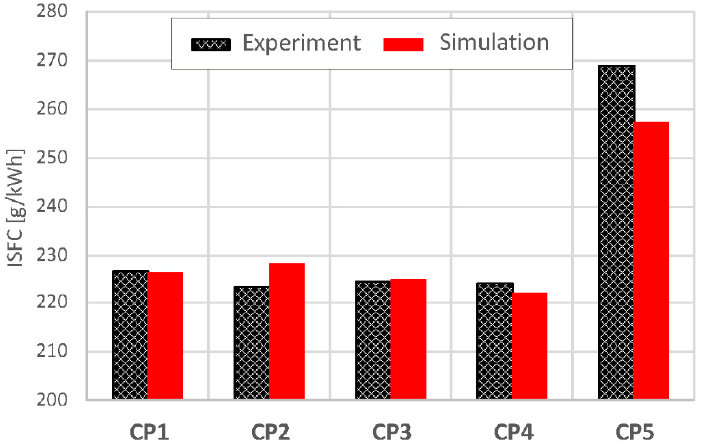
Figure 10. Experimental and 0D/1D simulation results for indicated specific fuel consumption (ISFC) over calibration points.